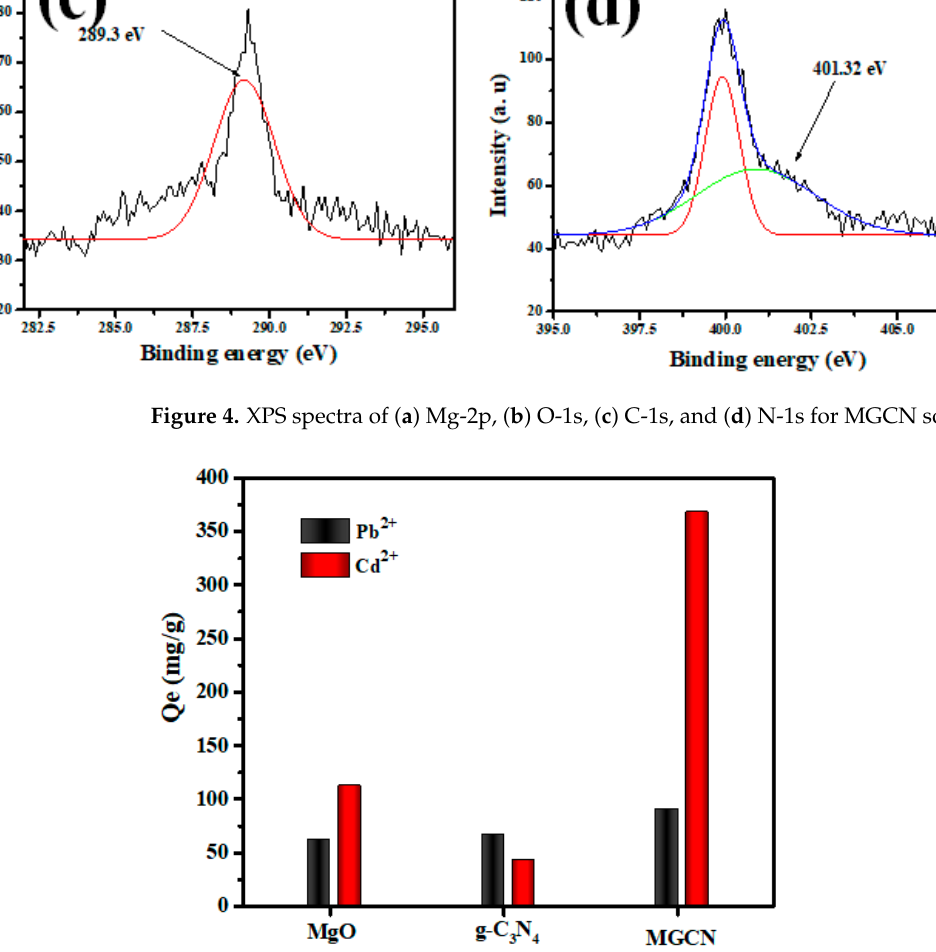
pH Figure 6. Effect of pH on the removal of Pb ++ /Cd ++ by MGCN nanosorbent.